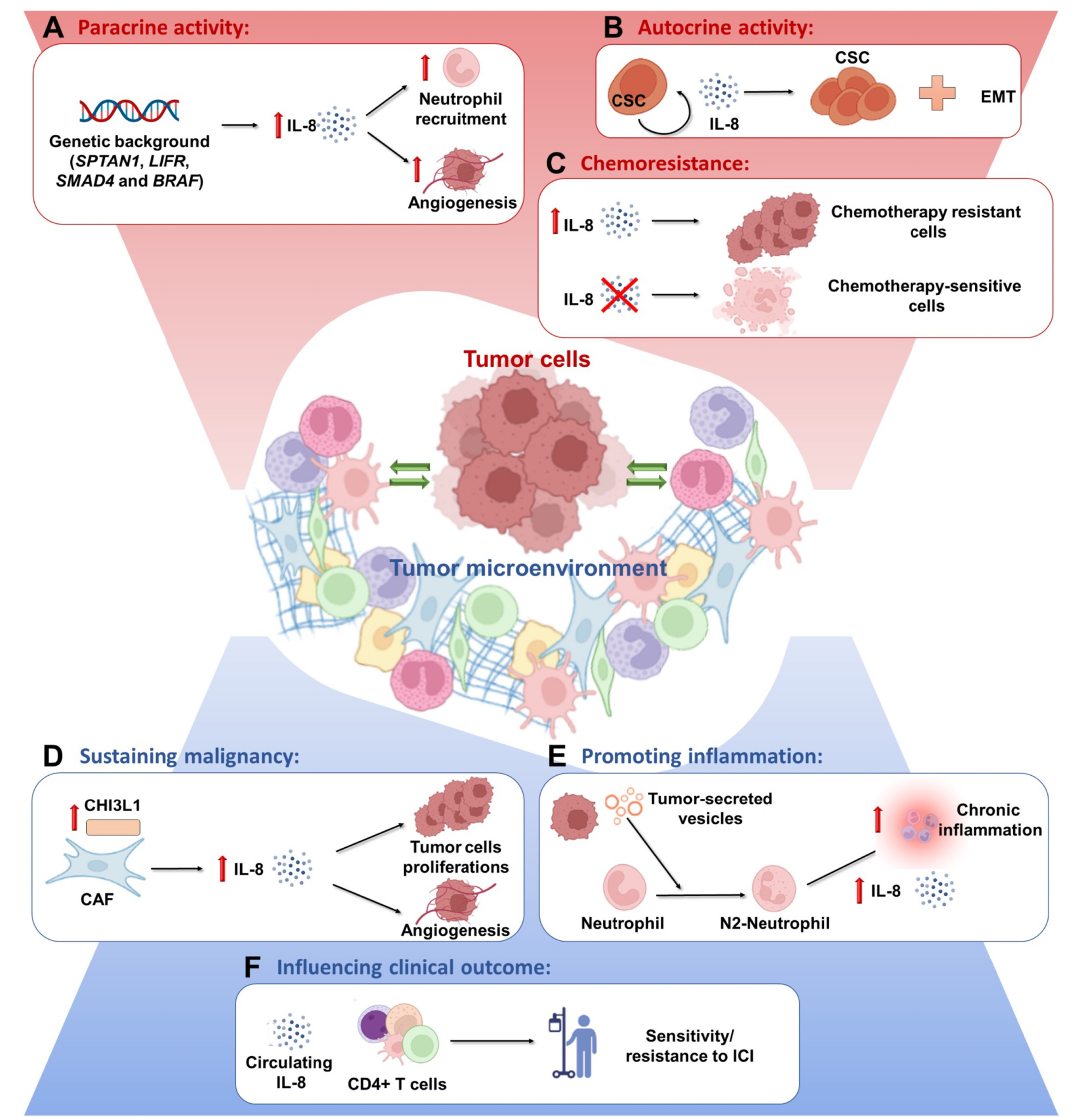
Figure 1. Functional consequences of IL-8-mediated crosstalk between tumor and stromal/immune cells within the TME. In the TME, both tumor and stromal/immune cells can release IL-8, which in turn acts as an autocrine or paracrine soluble factor. By mediating TSI, the IL-8 axis affects drug resistance, tumor progression, and clinical outcome in CRC patients. Top panel (in red): IL-8 production by CRC cells during tumor progression is influenced by their genetic background and regulated by the activity of genes such as SPTAN1 , LIFR , SMAD4 , or BRAF . Once released in the TME, tumor cells-derived IL-8 sustains the acquisition of a local pro-tumoral niche by stimulating neutrophil recruitment and promoting angiogenesis in a paracrine fashion ( A ). At the same time, IL-8 sustains CSC proliferation and EMT in an autocrine fashion ( B ), resulting in increased tumor aggressiveness and chemoresistance ( C ). Bottom panel (in blue): On the other hand, IL-8 can be produced by TME components and modulate TSI, inflammation, and immune response. For example, CAF may stimulate IL-8 release, thereby sustaining CSC proliferation and further promoting angio- genesis locally ( D ); under stimulation by tumor-secreted micro-vesicles, pro-tumoral N2-neutrophils promote chronic inflammation ( E ) both locally and systemically, resulting in high levels of IL-8 in the circulation and tissues which, in turn, influences the composition of tumor-infiltrating immune populations and sensitivity/resistance to ICI ( F